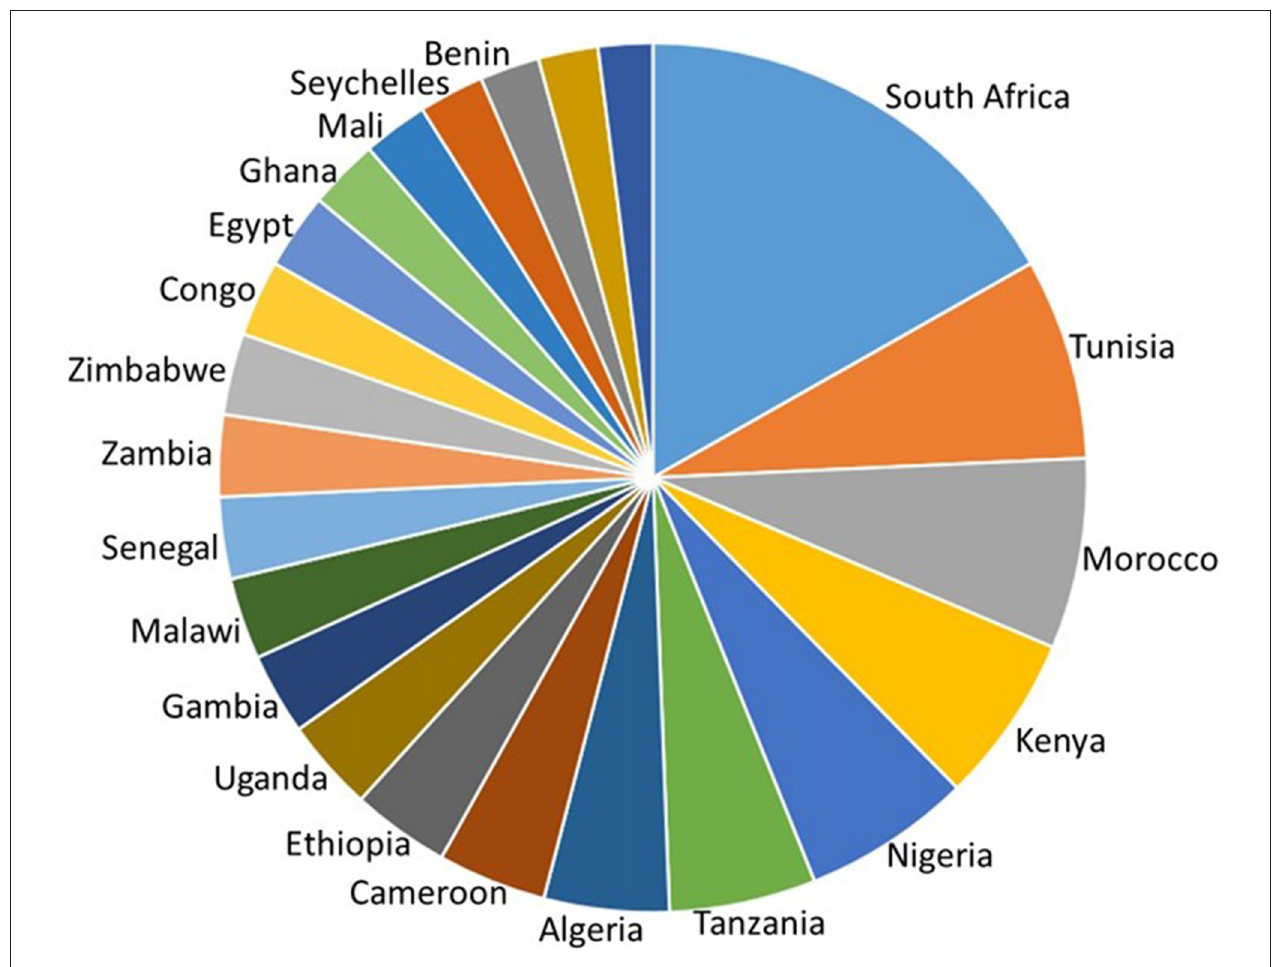
FIGURE 1 | H-index of countries in Africa calculated as the number of neuroscience publications that have each been cited at least that number of times in other articles. South Africa, Tunisia, Morocco, Kenya, Nigeria, Tanzania, Algeria and Cameroon have the highest country H index. Adapted from SCImago (2007) http://www.scimagojr.com/countryrank.php?area=2800&region=Africa&order=h&ord=desc and